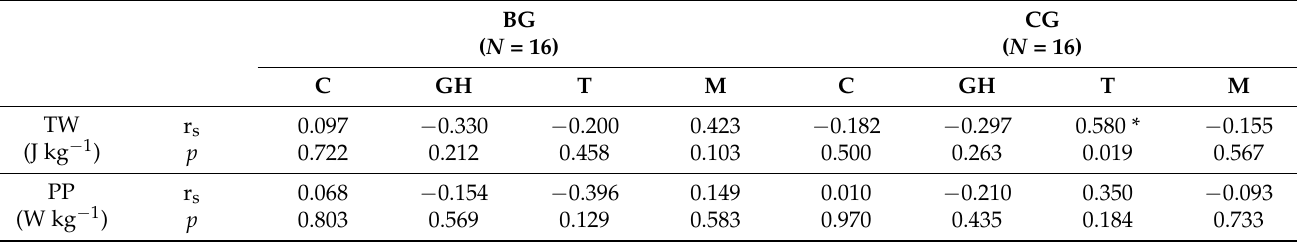
Table 3. Results of the Spearman’s signed-rank correlation test examining the relationship between total work and peak power and the hormones measurements from 10:00 a.m.